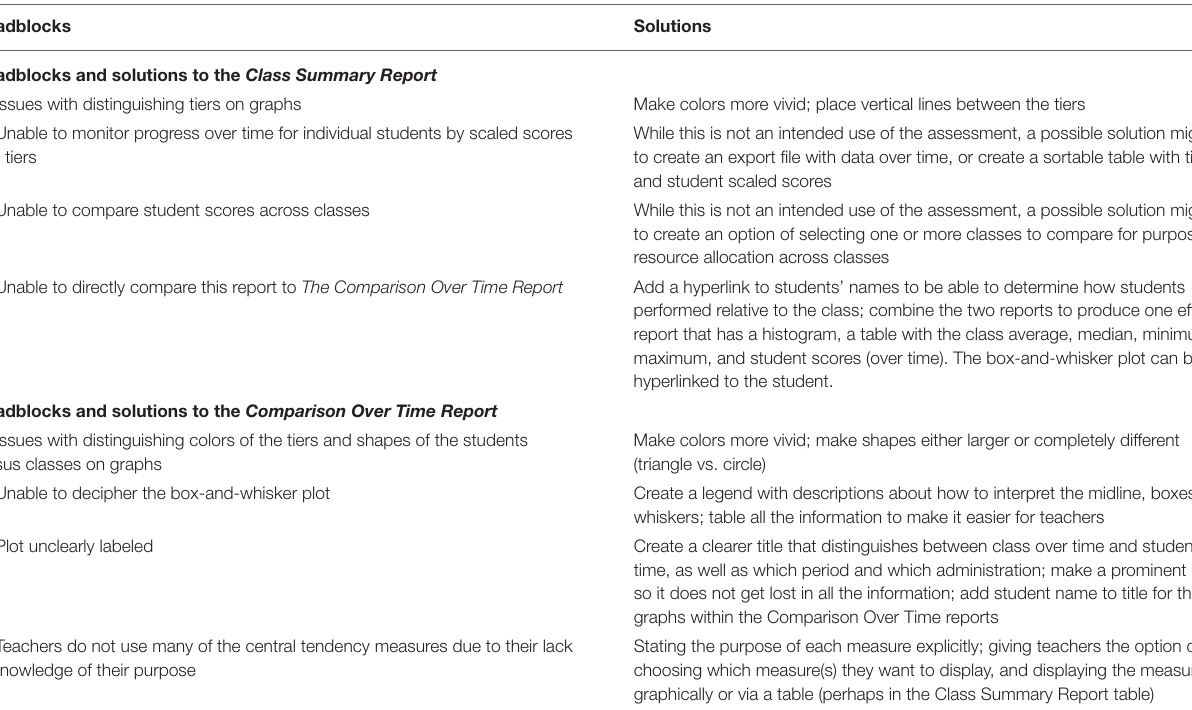
TABLE 1 | Roadblocks and solutions to the Class Summary Report and the Comparison Over Time Report . Roadblocks Solutions Roadblocks and solutions to the Class Summary